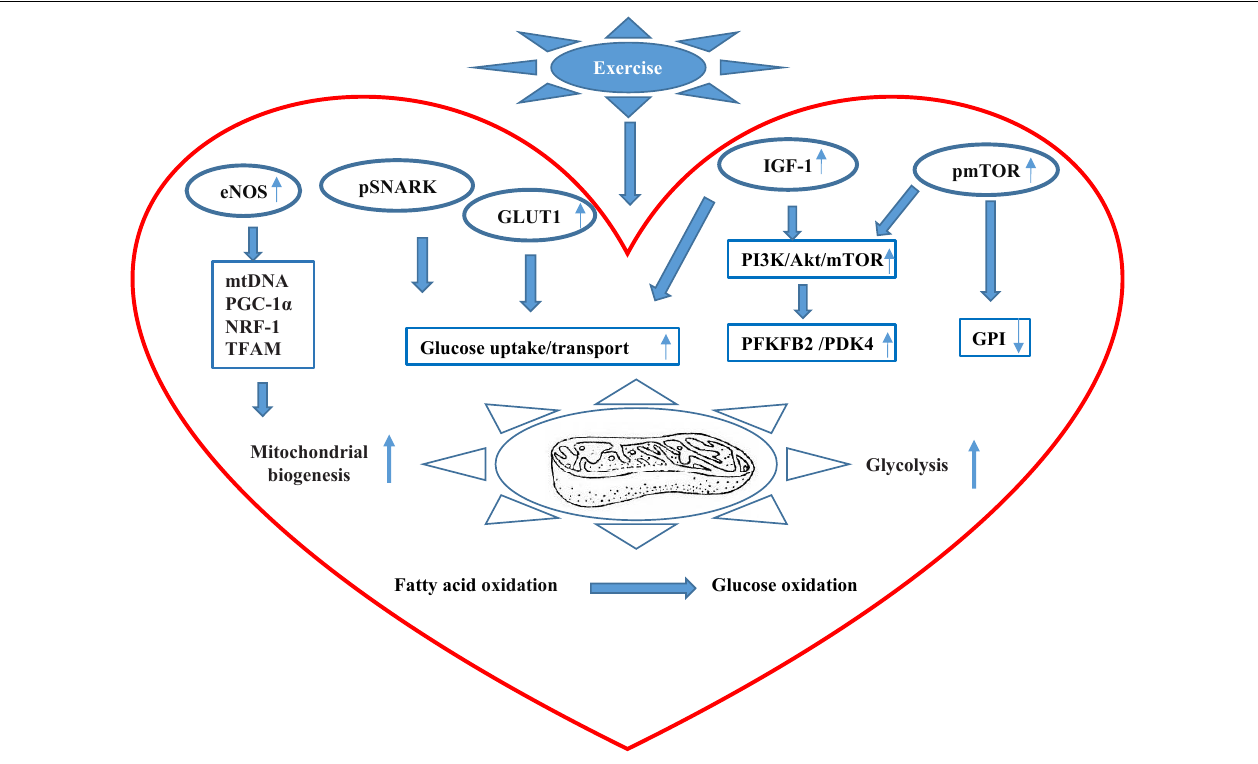
FIGURE 1 | The scheme of major mechanisms of exercise-promoted metabolic remodeling in the heart summarized in this review. Exercise can improve cardiac mitochondrial biogenesis through the eNOS signaling pathway that promotes mitochondrial DNA (mtDNA) content, peroxisome proliferator-activated receptor γ coactivator 1 α (PGC-1 α ), nuclear respiratory factor 1 (NRF-1), and mitochondrial transcription factor A (TFAM). Exercise can also upregulate the phosphorylation level of sucrose non-fermenting AMPK-related kinase (SNARK), enhancing glucose uptake and utilization. Besides, exercise stimulates circulating insulin-like growth factor (IGF-1) and insulin that increase overall glucose transport and uptake and also upregulates serine phosphorylation of 6-phosphofructo-2-kinase/fructose-2,6-biphosphatase 2 (PFKFB2) that boost glycolysis in the heart. In addition, exercise augments the activation of the mammalian target of rapamycin (mTOR) and reduces the activity of glucose 6-phosphate isomerase (GPI). Systemically, exercise can stimulate peripheral fatty acid mobilization from adipose tissue, and increased palmitoleic acid (C16:1n7) stimulates Akt phosphorylation that mediates metabolic remodeling in the